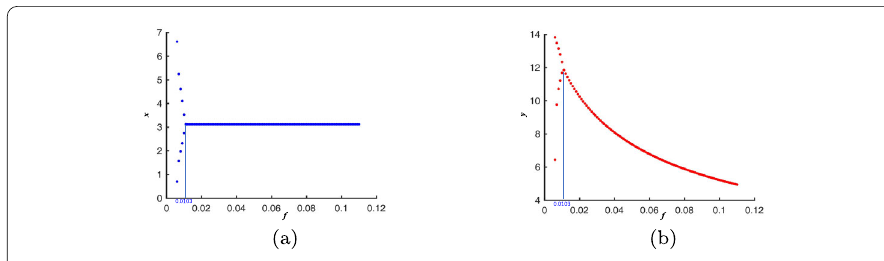
Figure 7 Bifurcation diagrams with parameter n for r = 6, a = 0.1. ( a ) The variation of x with f ; ( b ) variation of y with f